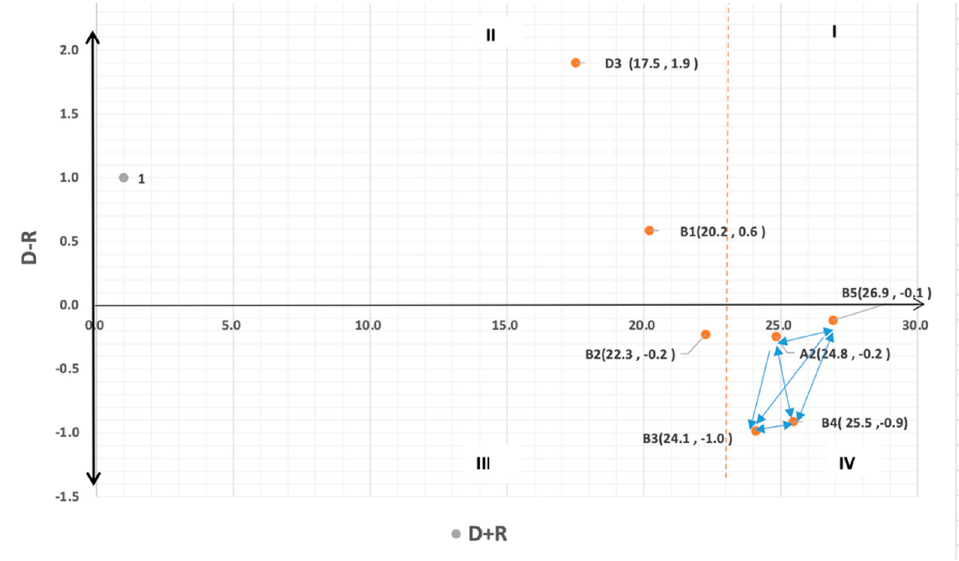
Figure 1. Cause–effect diagram of seven service performance indicators.